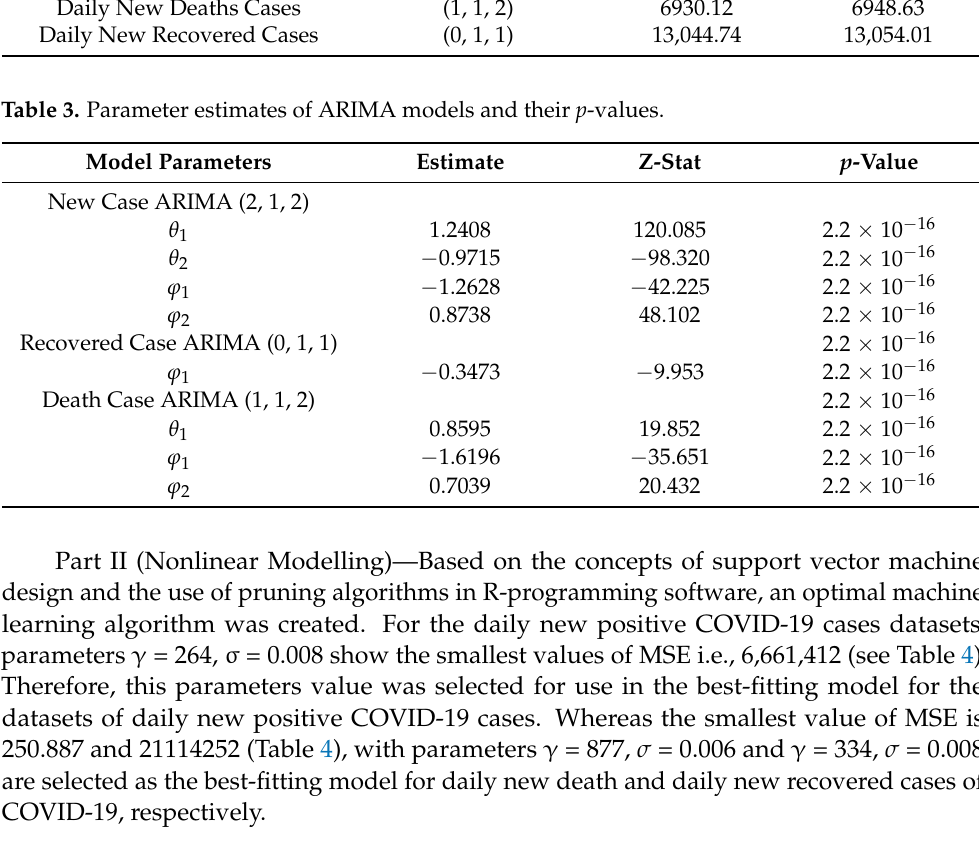
Table 4. LSSVMs Model Parameters for the daily new COVID-19 cases